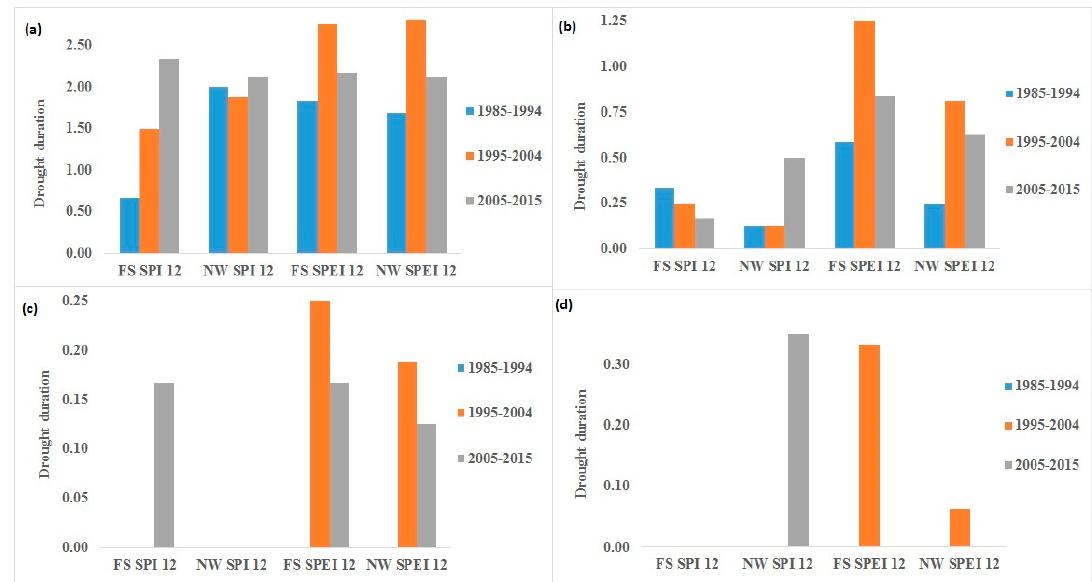
Figure 12. Drought duration (measured in months) based on SPI and SPEI 12 indices: ( a ) mild drought; ( b ) moderate drought; ( c ) severe drought; and ( d ) extreme drought.